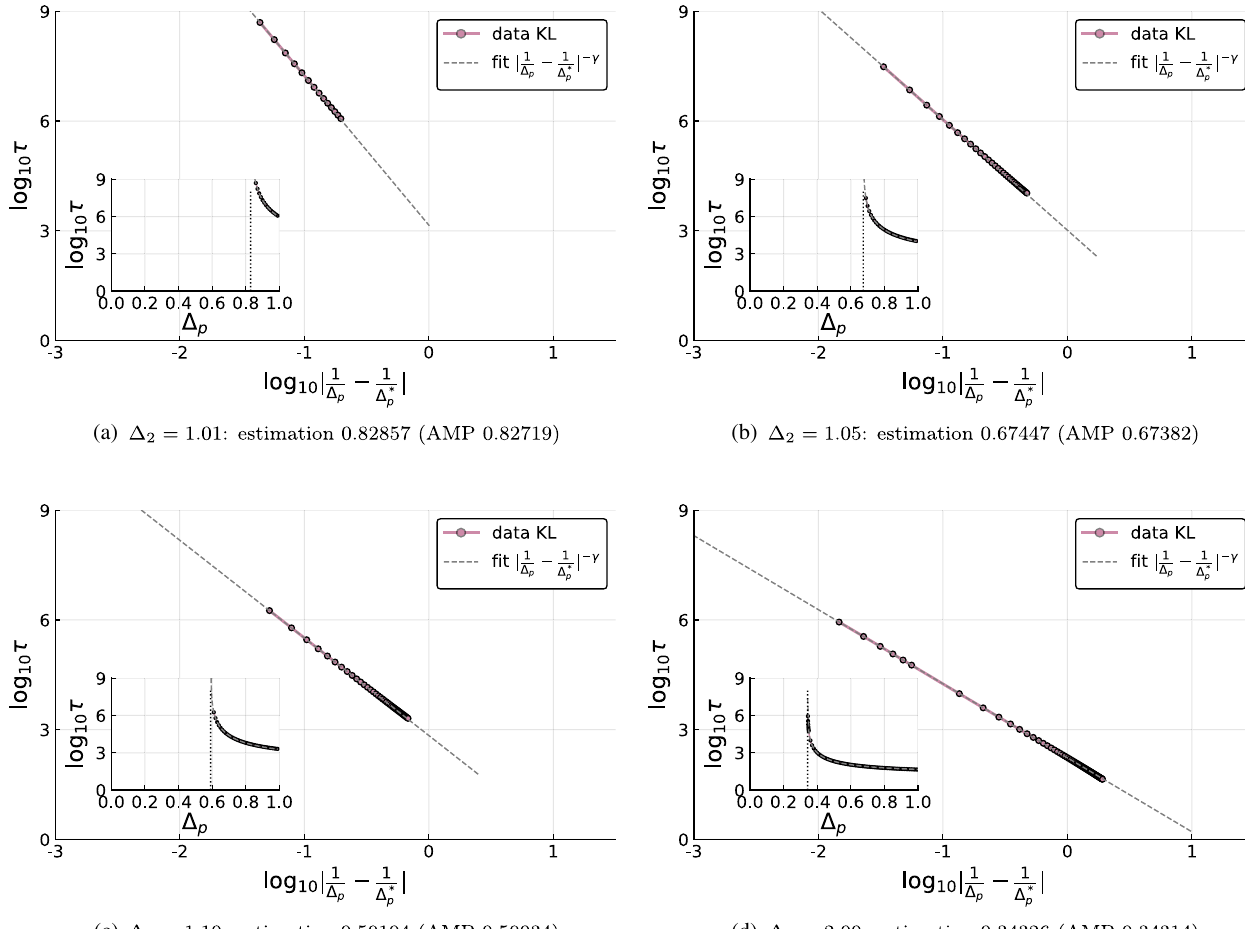
FIG. 17. Relaxation time obtained from the LSE starting from an informative initial condition model and are fitted with a power law, and the relaxation time appears to diverge very close to the point predicted by AMP (the AMP prediction is given in the